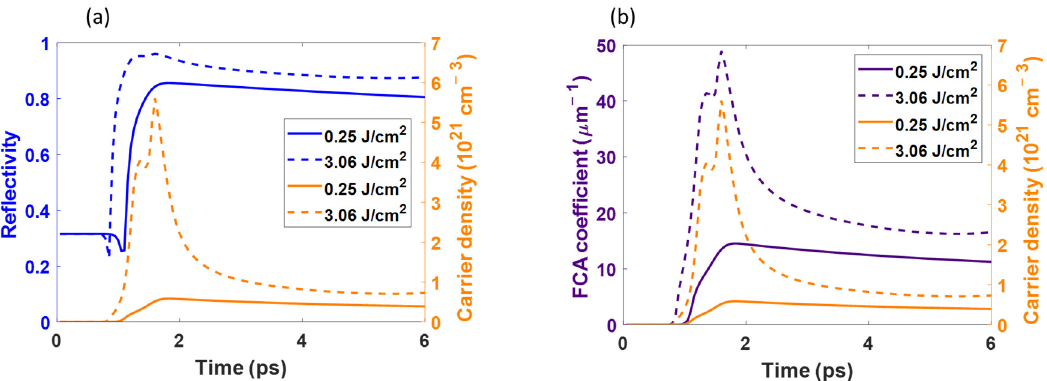
Figure 5. The temporal and dynamic optical properties and carrier density calculated by di ff erent laser fl uences: ( a ) Dynamic re fl ectivity and ( b ) Free-carrier absorption coe ffi cient. laser fluences: ( a ) Dynamic reflectivity and ( b ) Free-carrier absorption